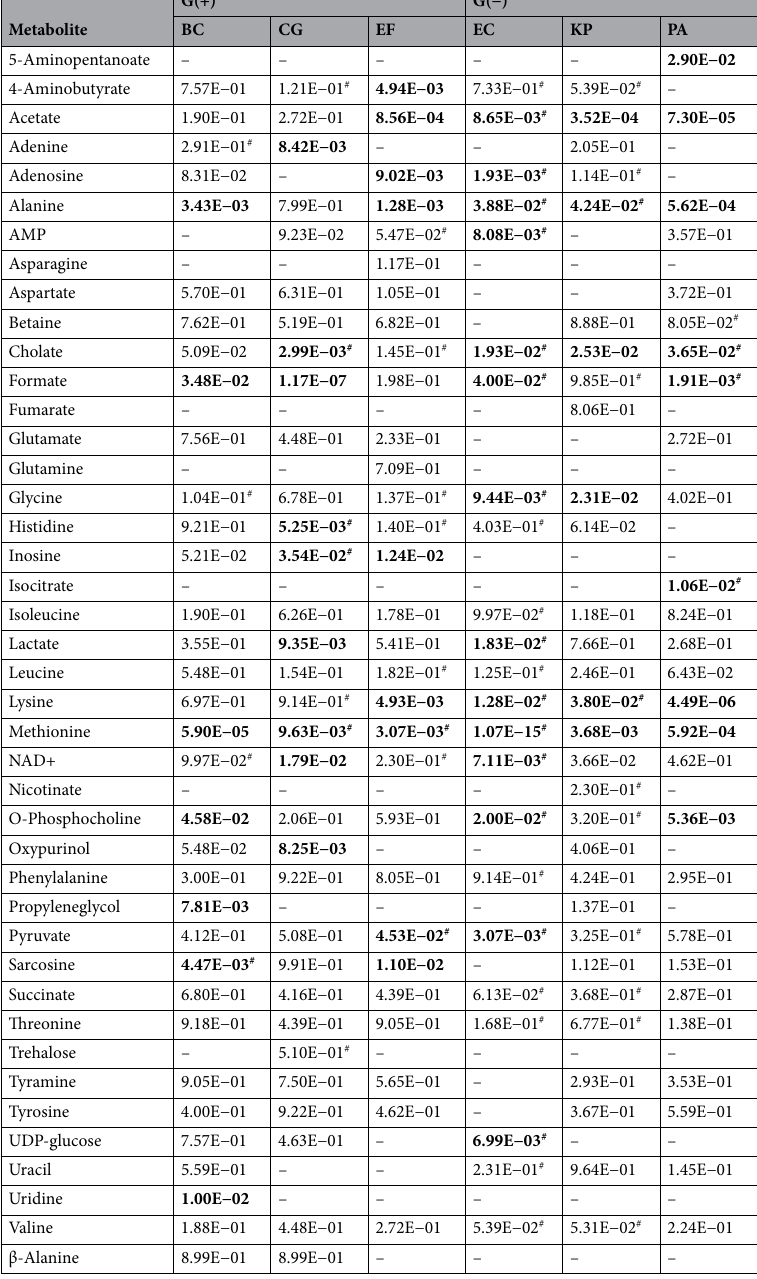
Table 2. The p-values resulting from analysis of variance between three disintegration methods in each bacteria strain (BC— B. cereus ; CG— C. glutamicum ; EF— E. feacalis ; EC— E. coli ; KP— K. pneumoniae ; PA— P. aeruginosa ). # Kruskal–Wallis test; bold—results with p-value <